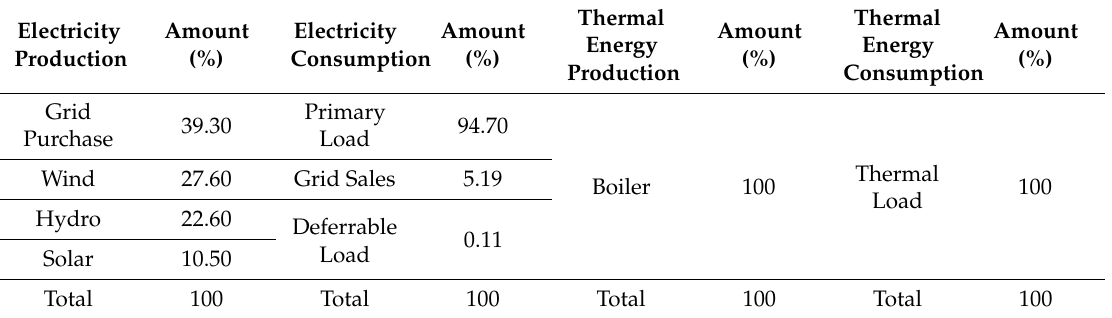
Figure 10. ( a ) Conventional small-scale fossil fuel-based grid-connected thermal and renewable energy sources-based hybrid energy system; ( b ) Conventional small-scale fossil fuel-based off-grid thermal and renewable energy sources-based hybrid energy system. Table 11. Energy production and consumption scenario of grid-connected mode for the first year of project life (case-03).